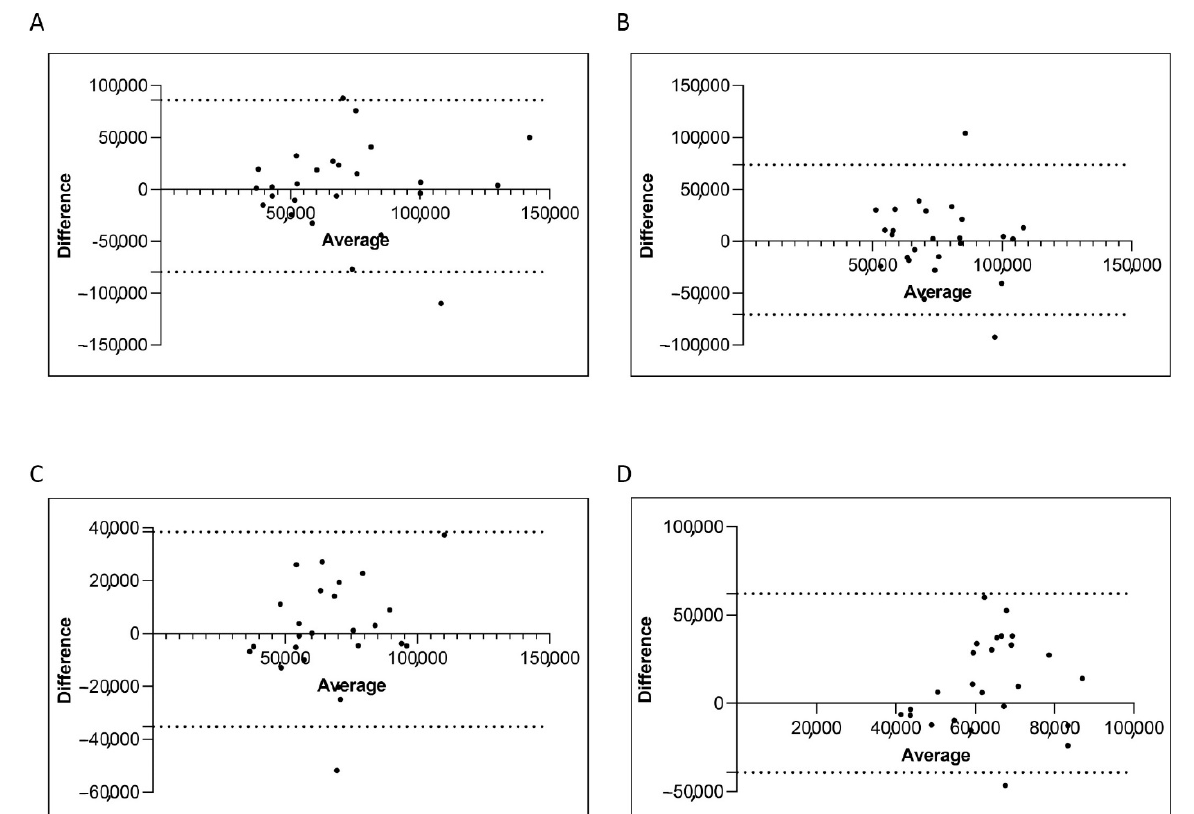
Figure 7. Bland–Altman showing the concordance of the ABL1 level measured by manual and semiautomatic methods. Paired measurements of ABL1 were combined for patients stratified in four groups, each consisting of 25 subjects: Group A (10% > BCR-ABL1/ABL1 IS > 0.1%) ( A ), Group B (0.1% > BCR-ABL1/ABL1 IS > 0.01%) ( B ), Group C (0.01% > BCR-ABL1/ABL1 IS > 0.0032%) ( C ) and Group D ( BCR-ABL1/ABL1 IS < 0.0032%) ( D ). The graph is plotted on the XY axis where X represents the difference of the two measurements, and the Y -axis shows the mean of the two measurements. Horizontal lines are drawn at the mean difference between the two methods and the upper and lower limits of agreement. The 95% confidence intervals are shown for the mean and the upper and lower limits of agreement.